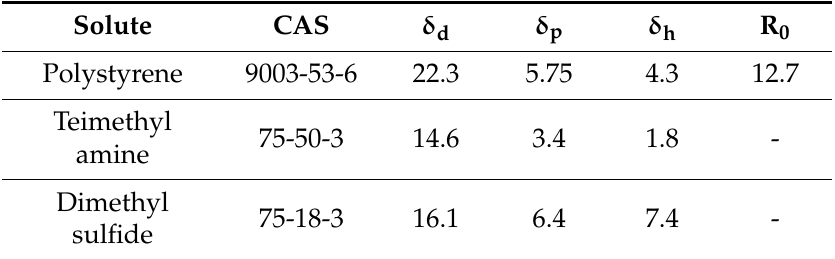
Table 1. Hansen solubility parameters of each